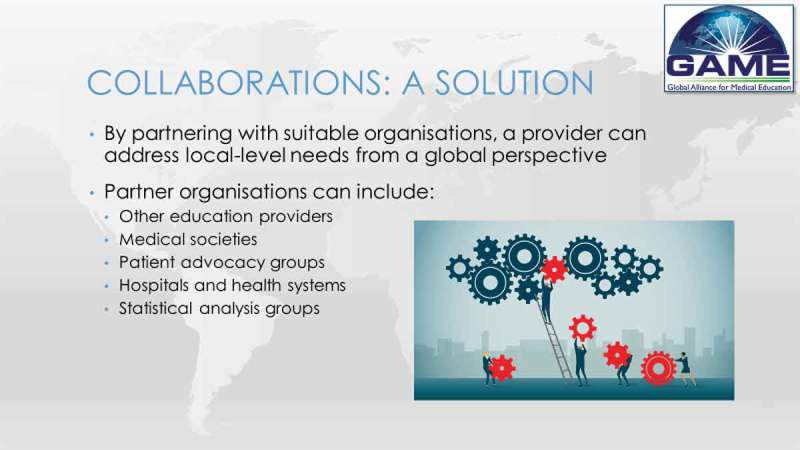
Global partnerships.